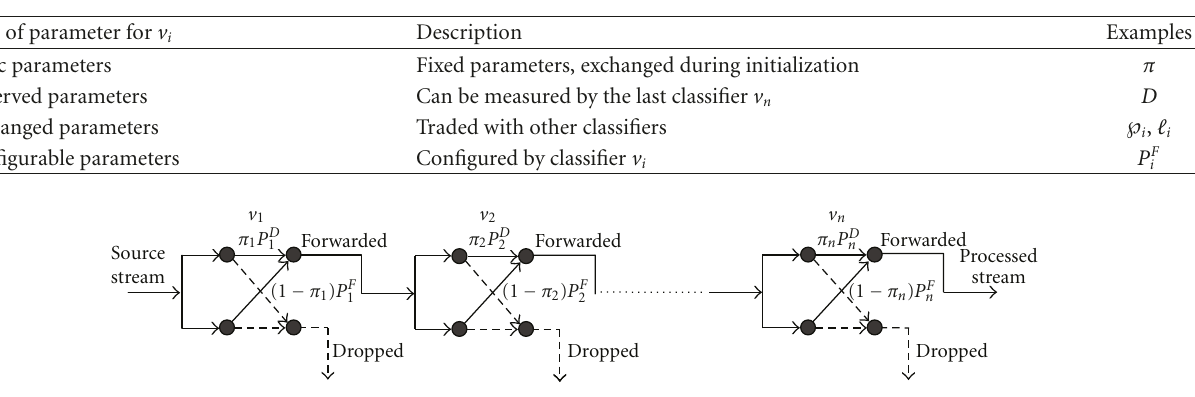
Table 1: Summary of parameter types and a few examples.